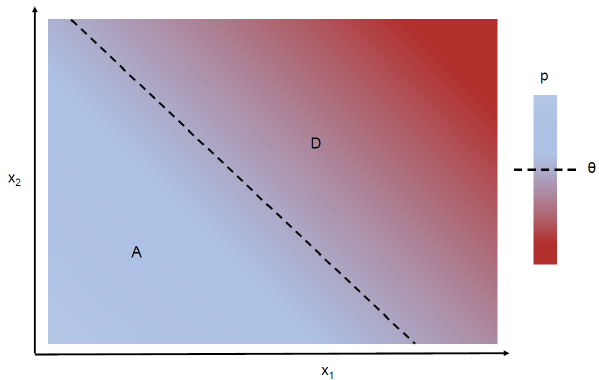
Figure 1. Concept of the response surface as a stress test with de- scriptive variables ( x 1 , x 2 ). Acceptable and unacceptable regions are defined by a threshold θ over performance R